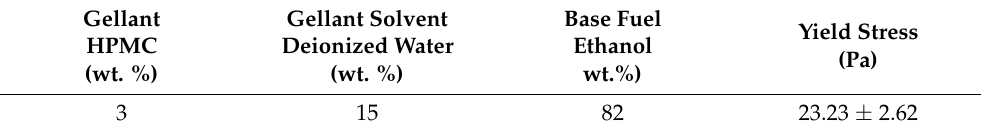
Table 1. The composition of organic gellant-based ethanol gel fuel. Gellant